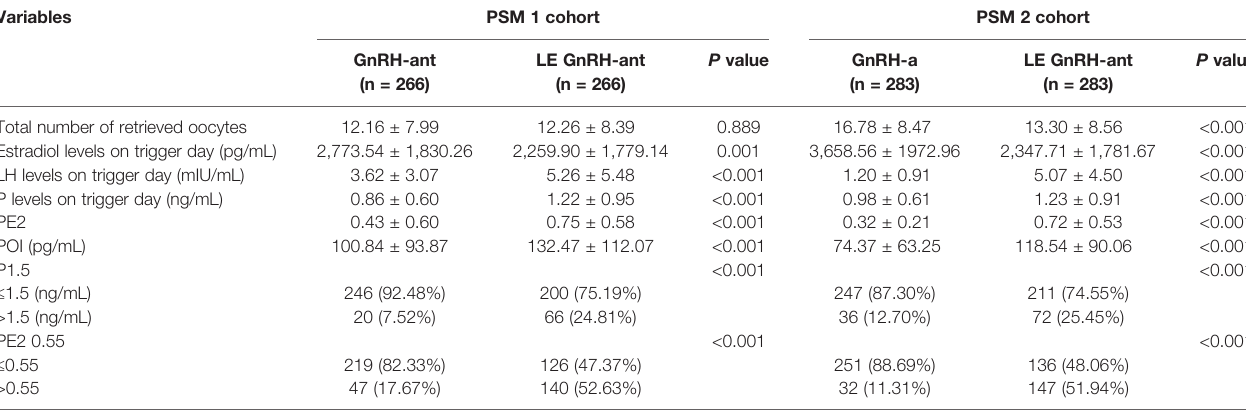
TABLE 2 | Results of ovulation induction after propensity score matching.